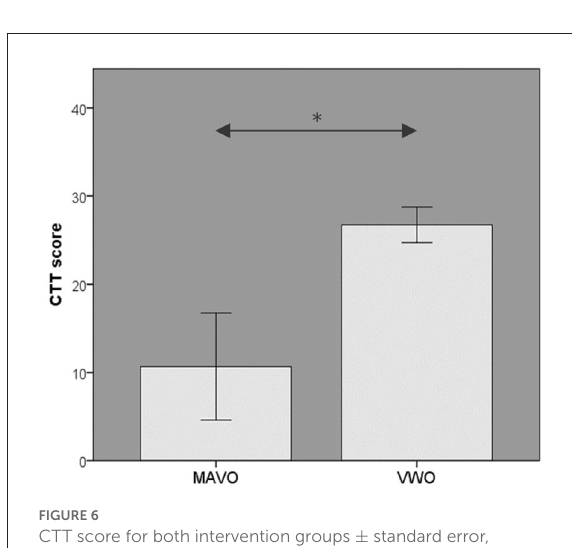
FIGURE7 Correlation for CTT and TOLT scores ± standard error, (cid:13) = outlier. Shown is the scatterplot for the CTT and post-TOLT scores of the whole